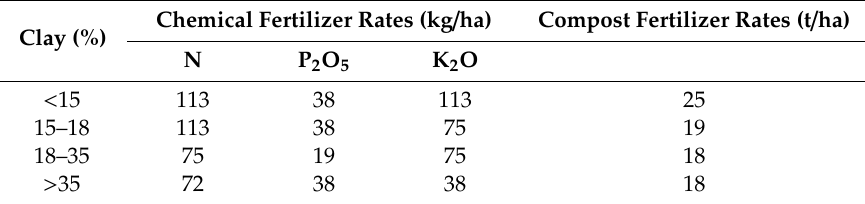
Table 1. Chemical and compost fertilizer application guidelines based on clay content for sugarcane in Thailand [22,23]. Chemical Fertilizer Rates (kg / ha) Clay (%)